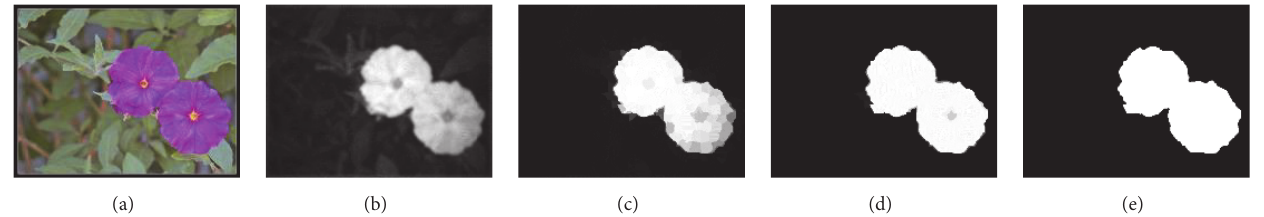
Figure 1: Main framework of the proposed approach. (a) Input image. (b) Coarse saliency map. (c) Saliency map after edge-preserving element-level filtering. (d) Final saliency map after geodesic distance refinement. (e) Ground